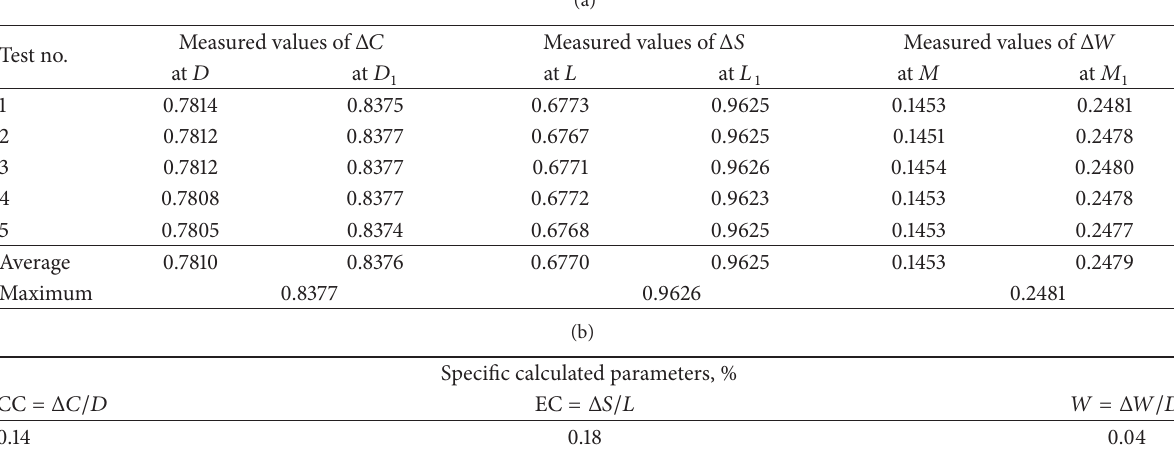
Table 8: The classification results of tile second sample using new measurement method in mm.